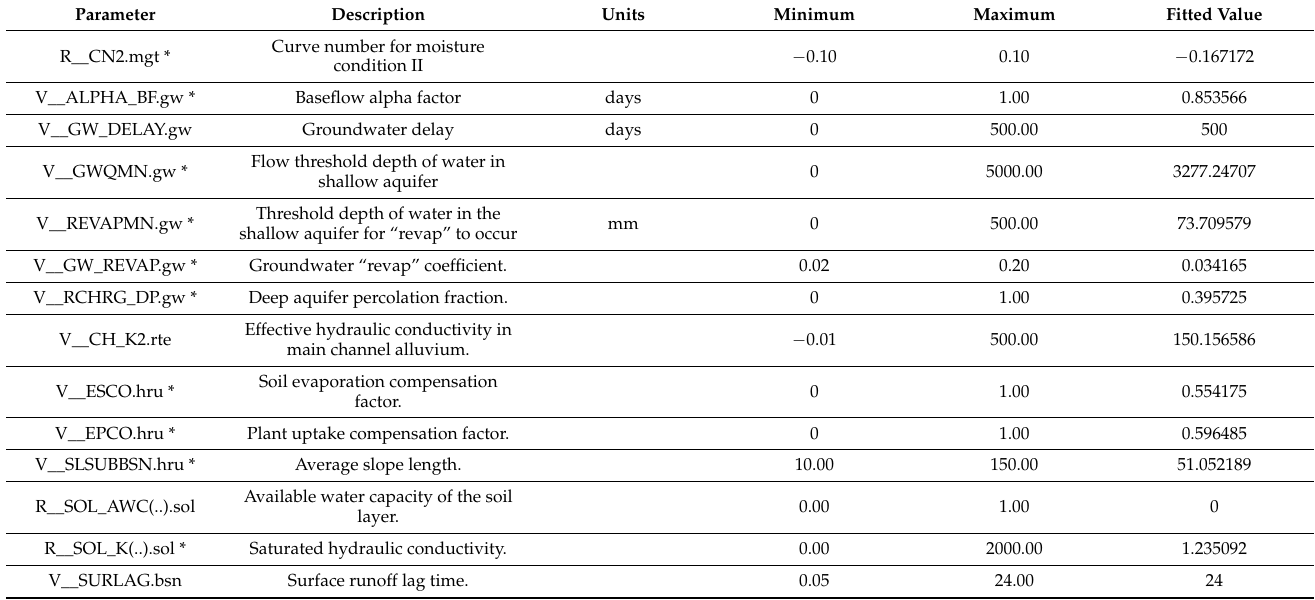
Table 5. Parameters used in the flow calibration procedure between 2000 and 2010 in the Paraopeba River Basin. In the method legend, R is relative and V is the replacement value. (*) represents statistically significant parameters ( p ≤